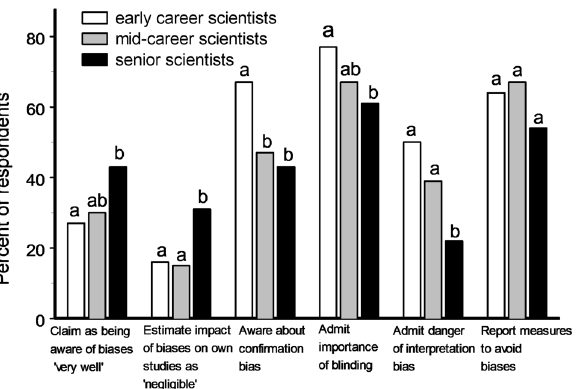
Figure 3. Selected characteristics of the respondents’ attitudes to biases in relation to the stages of their research careers, as reported by 124 early career, 50 mid-career and 97 senior scientists. Bars marked with different letters differ from each other at P < 0.05 within each group ( χ 2